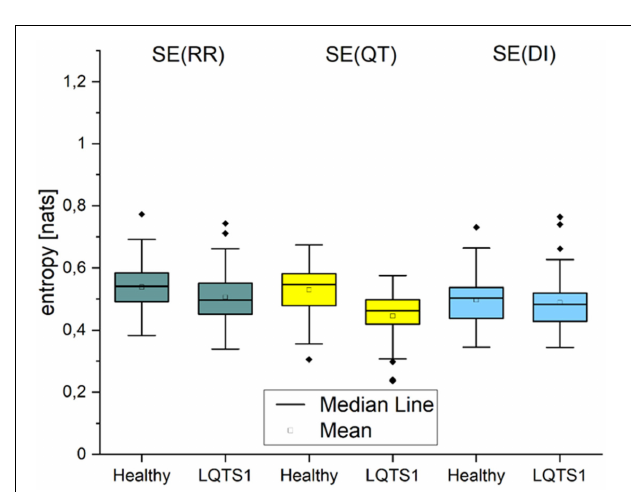
FIGURE 3 | New information produced in the processes: RR intervals, QT intervals, and diastolic intervals, respectively. The Kolmogorov–Smirnov test was used, p -values: 0.3517 [N(RR)], 0.01124 [N(QT)], and 0.11007 [N(DI)].